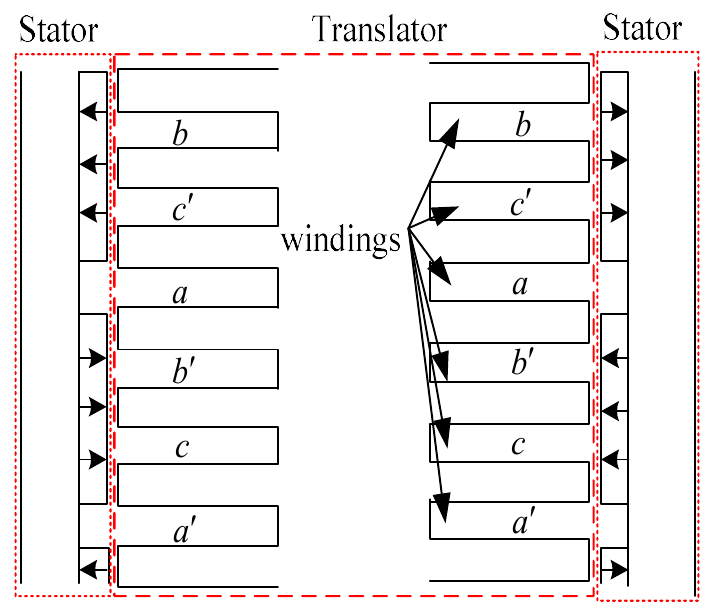
Figure 3. Cross-section of PMLSG.